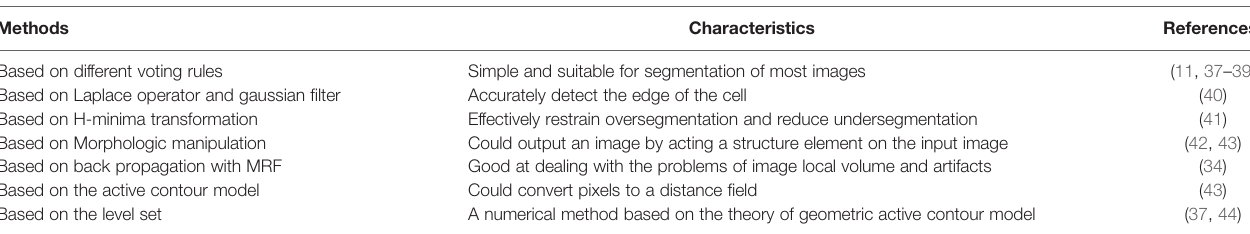
TABLE 2 | A summary of methods on segmentation after detection of individual